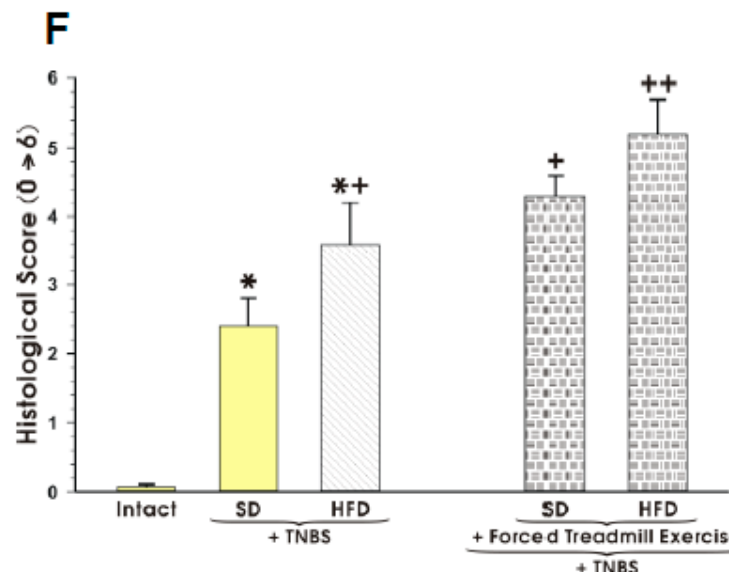
Figure 2. The representative gross (upper panel) and microscopic (lower panel) appearance of colon from intact ( A ), sedentary mouse with TNBS colitis fed standard diet (SD) ( B ), sedentary mouse fed high-fat diet (HFD) with colitis ( C ), sedentary mouse fed SD exposed to forced exercise training ( D ), or mouse fed HFD with colitis exposed to forced treadmill exercise ( E ) and the quantitative histology scores in non-exercising and exercising mice with colitis ( F ). In mice fed SD or HFD with colitis subjected to forced exercise, the enterocyte architecture is distorted revealing destroyed crypts, extended ulcerations and transmural inflammatory cell infiltrates ( D and E ) (arrows) as compared with mice fed either with SD or HFD but not exposed to forced treadmill exercise ( B and C ). These values of histopathological score were significantly increased in non-exercising and exercising mice fed HFD. An asterisk indicates a significant change ( p < 0.05) vs. intact colonic mucosa. An asterisk and cross indicate a significant change ( p < 0.05) as compared to sedentary mice fed SD. Cross indicates a significant change ( p < 0.05) as compared with respective values in sedentary mice fed SD. Double crosses indicate a significant change ( p < 0.05) as compared with respective values in exercising mice fed SD.